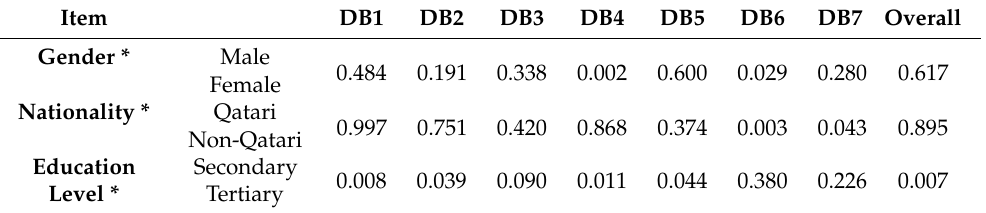
Table 5. Association between young drivers’ demographic background and psychosocial-behavioral